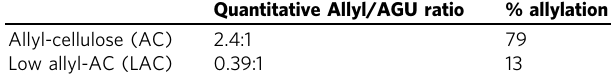
Table 1 Quantitative allyl/AGU ratios and the calculated % allylation values of AC and LAC were obtained via 13 C Inverse-gated Solid NMR